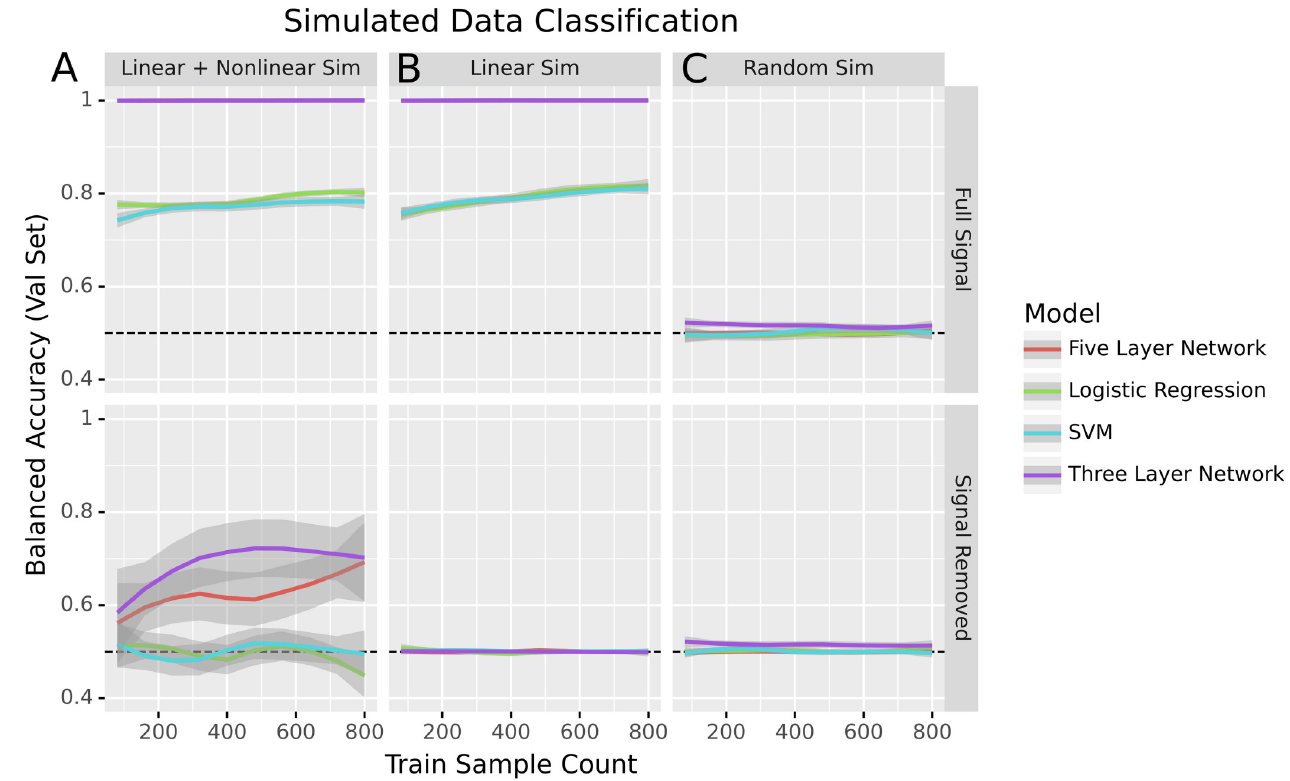
Fig 4. Performance of models in binary classification of simulated data before and after signal removal. Dotted lines indicate expected performance for a naive baseline classifier that predicts the most frequent class.